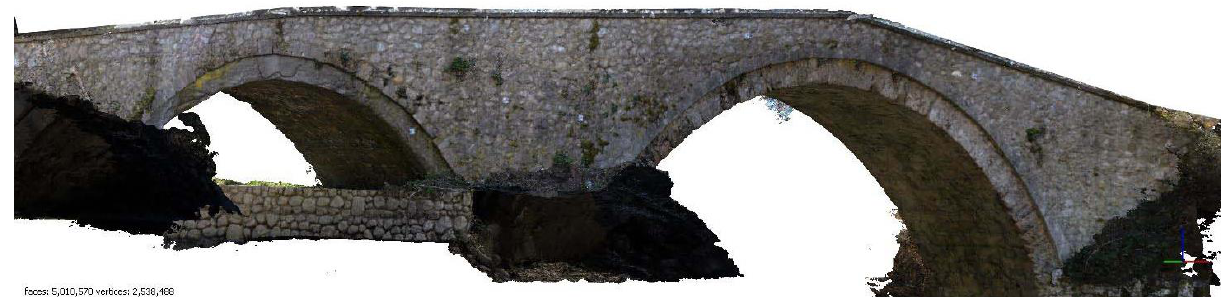
Figure 5 . Photogrammetric model of the